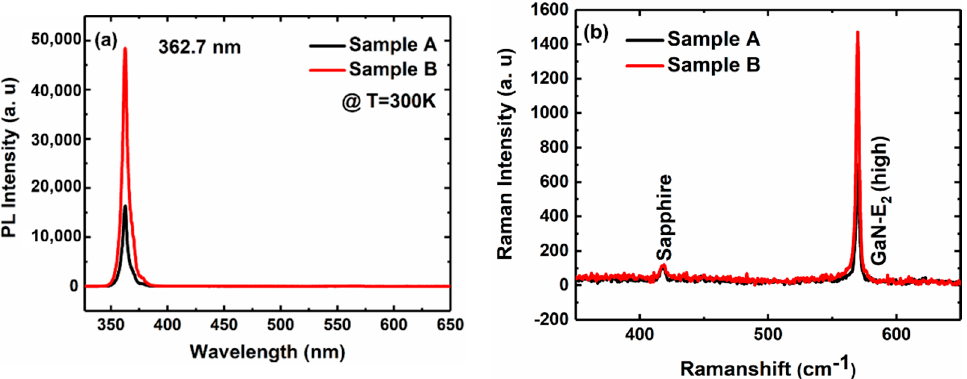
Figure 5. ( a ) PL and ( b ) Raman spectra of samples A and B at room temperature (300 K).